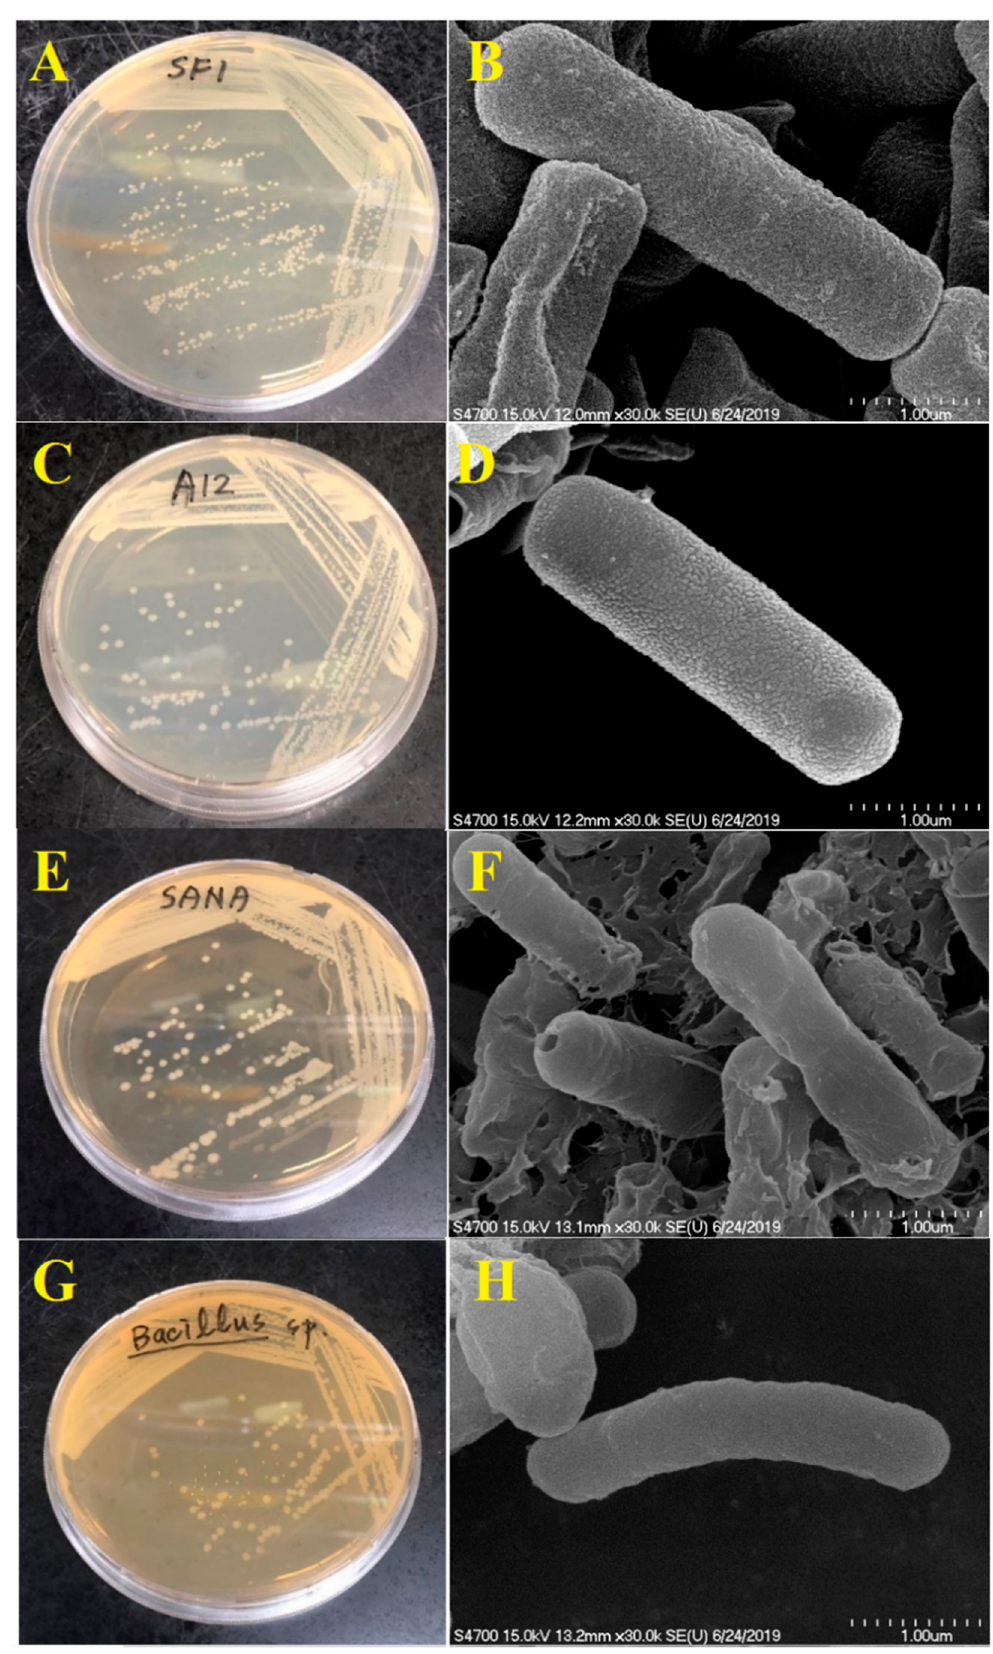
Figure 1. Colony morphology and scanning electron micrographs of isolated bacterial strains SF1 (Pseudmonas sp.) ( A , B ), A12 (Pseudmonas sp.) ( C , D ), SANA (Clostridium sp.) ( E , F ), and B (Bacillus sp.) ( G , H